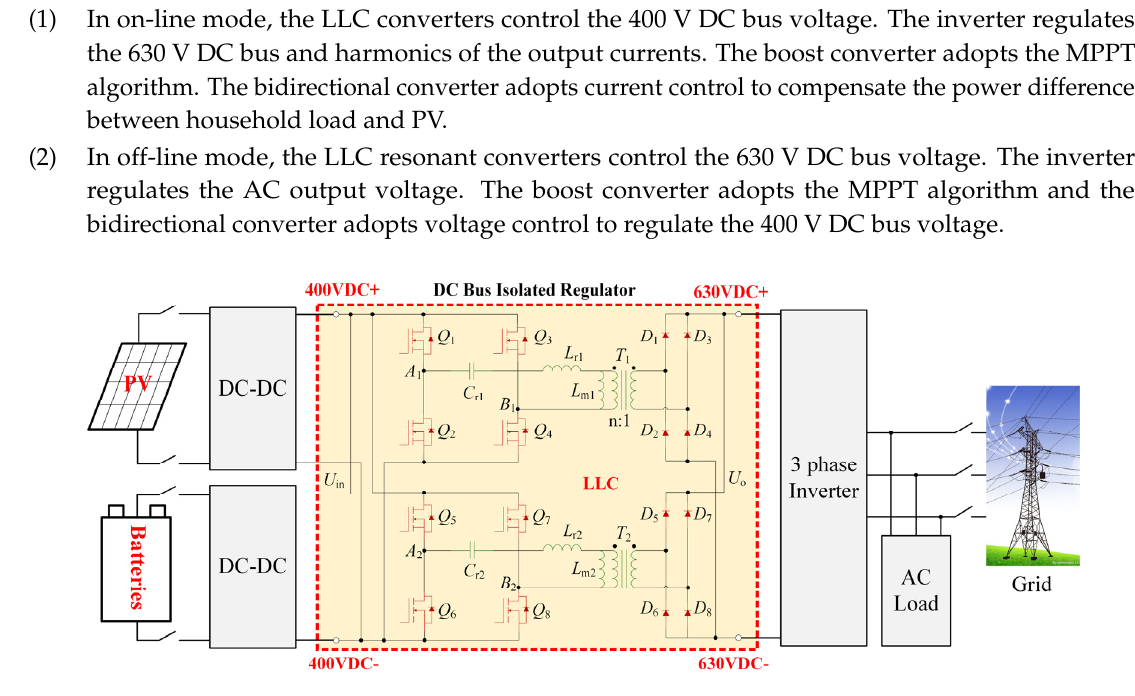
Figure 1. Architecture of residential photovoltaic system.